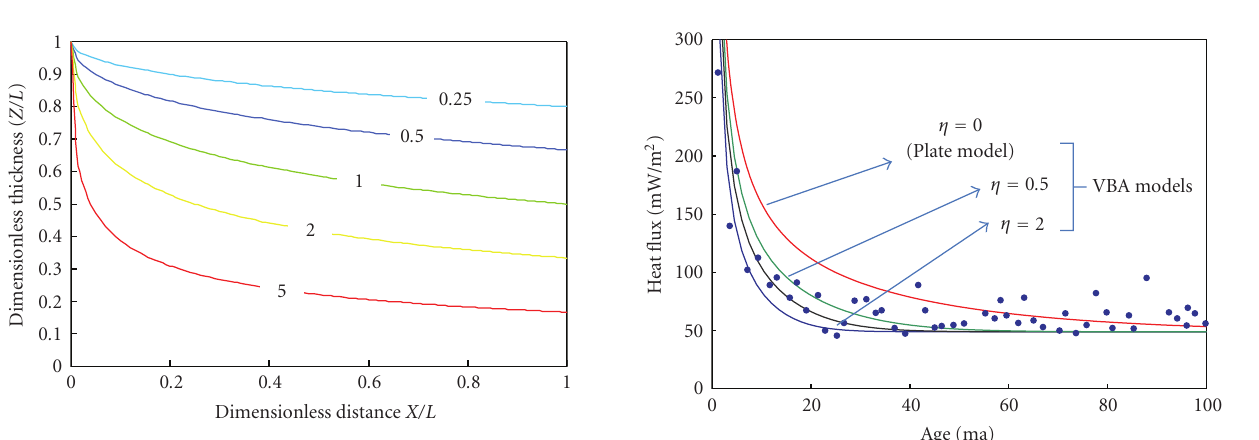
Figure 2: Decrease in thickness of the column of asthenospheric material as a function of the distance from the ridge axis,. The numbers on the curves are values of the parameter ( η ) in (1a) and (1b). See text for details.